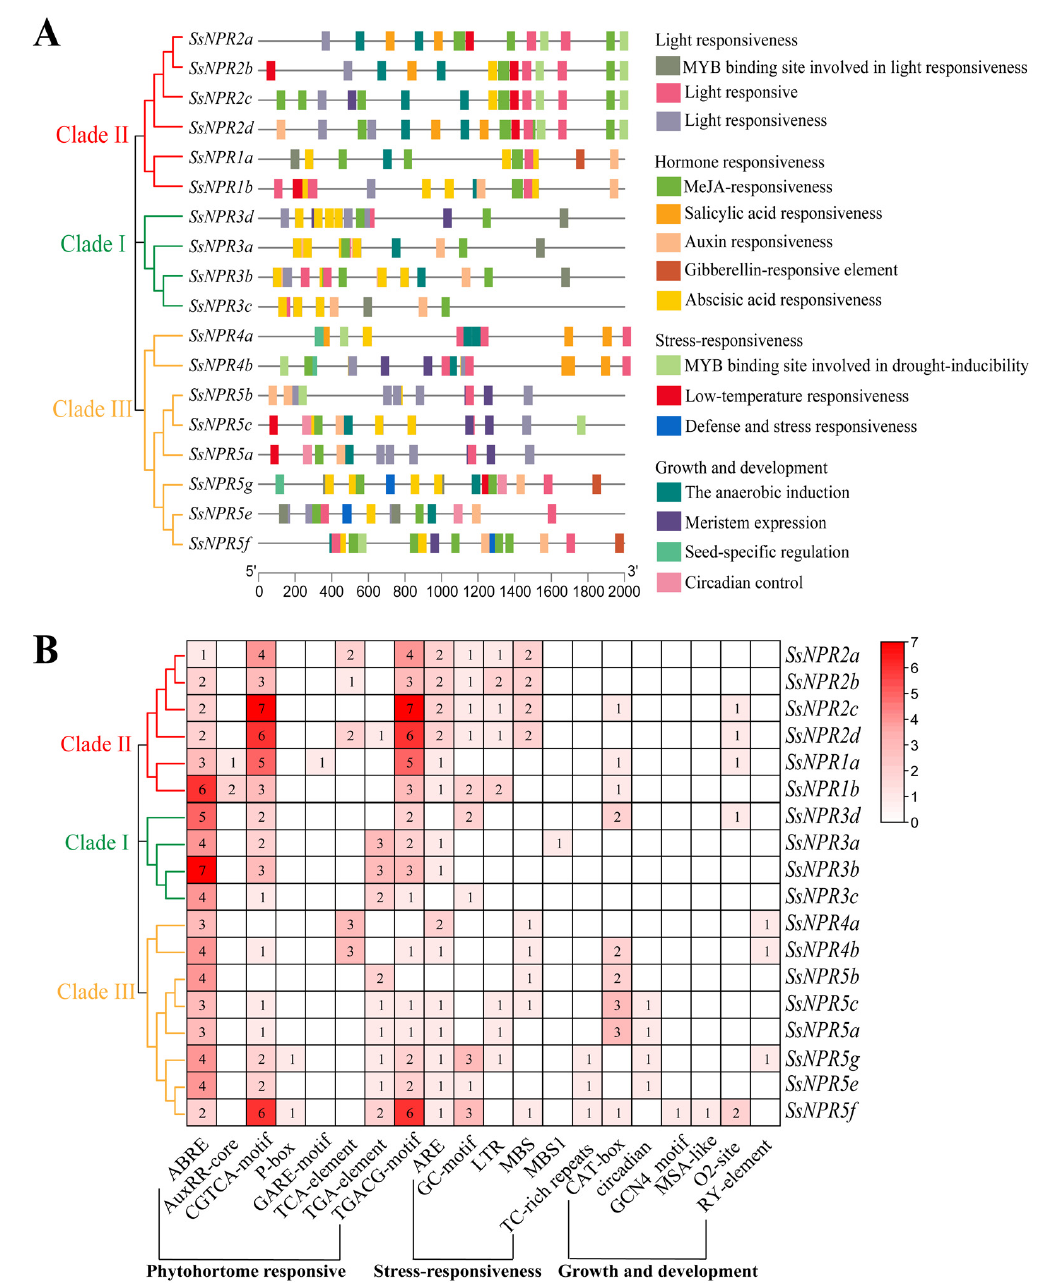
Figure 4. Cis -regulatory element (CRE) analysis of NPR1 -like gene family. ( A ) The location distri- bution of different kinds of CREs in the promoter region. Different colored boxes correspond to different kinds of CREs and some CREs may overlap with other CREs. ( B ) The number of CREs in the promoter region of the NPR1 -like genes. The number of each CRE is shown in the heatmap box, and blank indicates that there was no corresponding CRE. Different colors on the phylogenetic tree represent different groups of the NPR1 -like gene family.